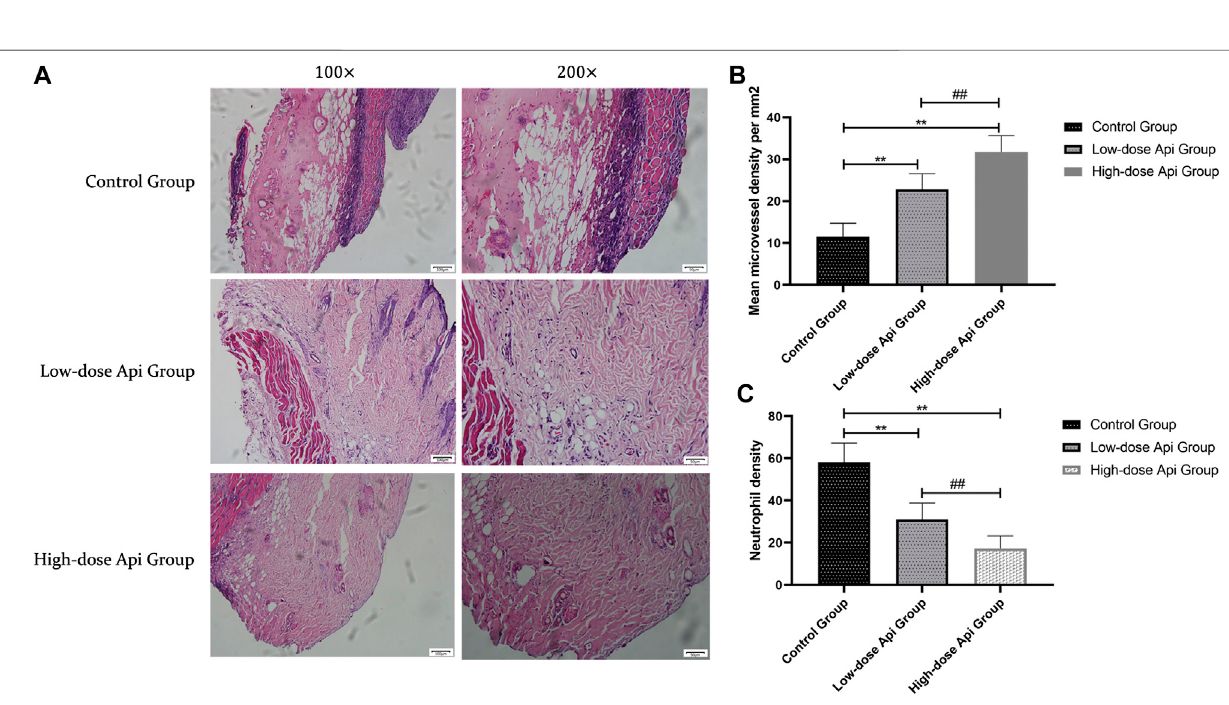
Frontiers in Pharmacology |